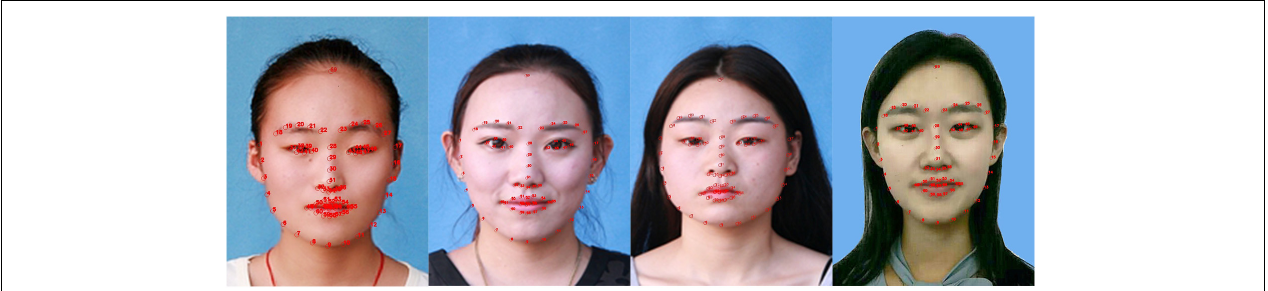
FIGURE 9 | Examples of four typical facial shapes: from left to right are square, oval, round, and heart. And the facial transverse/longitudinal ratio D1/D2 are 0.754, 0.791, 0.872, and 0.736, respectively (Clarification: written informed consents were obtained from the individuals for the publication of these images).